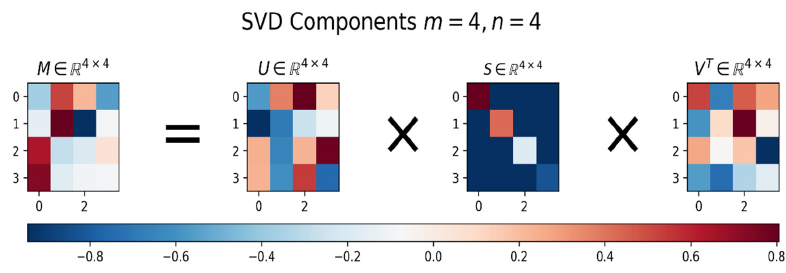
Figure 3. Singular value decomposition of a 4 × 4 matrix.